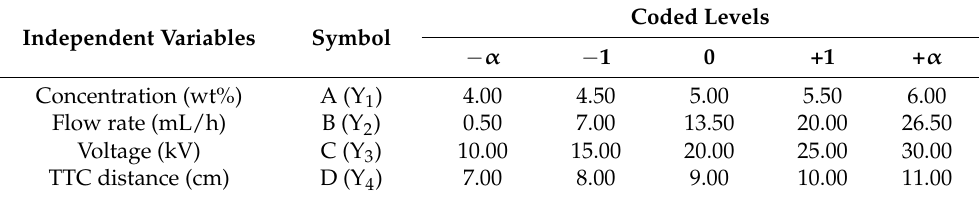
Table 1. Experimental design factors and coded levels for chitosan microcapsules. Independent Variables